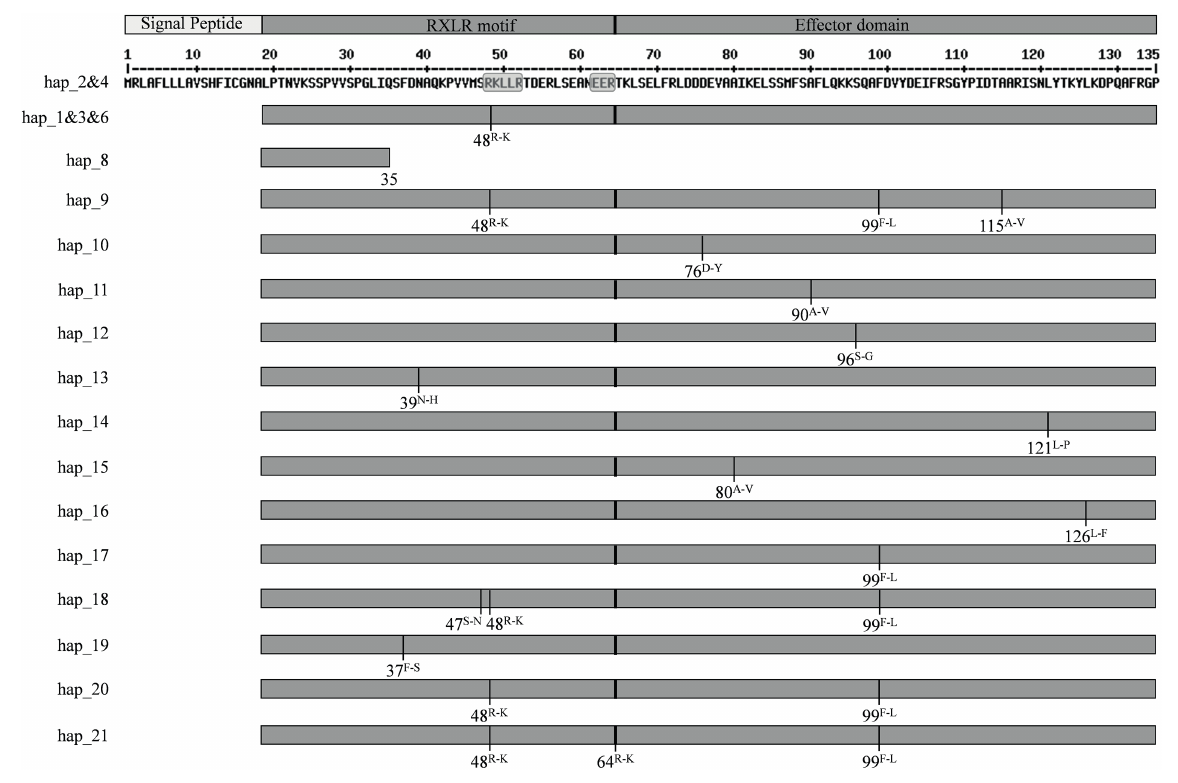
FIGURE 1 Sketch showing the Pi02860 structural domain and the mutation position in each of nucleotide haplotypes. Hap_5 and Hap_7 were removed due to a mutation in start